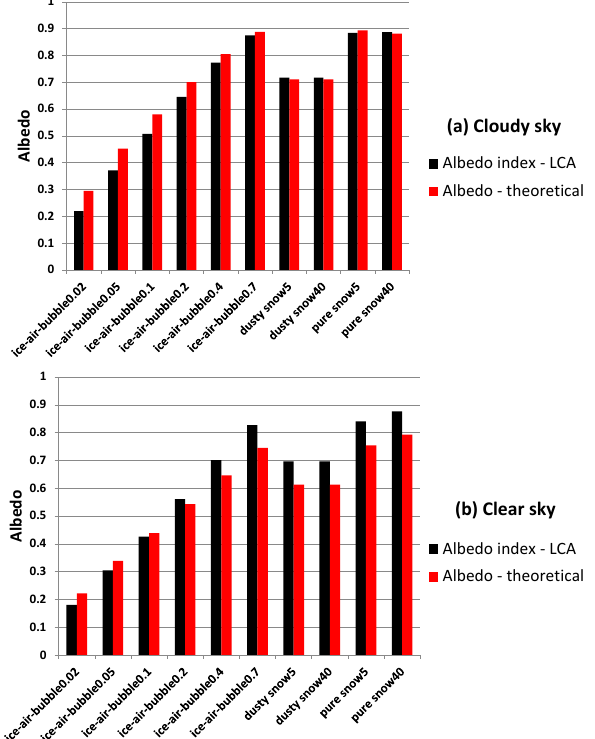
Figure 4. Comparison between the theoretical semi-infinite diffuse beam broadband albedo and LCA albedo index theoretically esti- mated based on spectral response of the LCA for 10 different sur- faces calculated with two kinds of total solar irradiance (see the text for the calculation). Cloudy sky (panel a ) and clear sky (panel b ) conditions (spectra are represented in Fig. 2). From left to right along the bottom axes: ice air bubble 0.02; ice air bubble 0.05; ice air bubble 0.1; ice air bubble 0.2; ice air bubble 0.4; ice air bubble 0.7; dusty snow SSA 5m 2 kg − 1 ; dusty snow SSA 40m 2 kg − 1 ; pure snow SSA 5m 2 kg − 1 ; pure snow SSA 40m 2 kg − 1 .